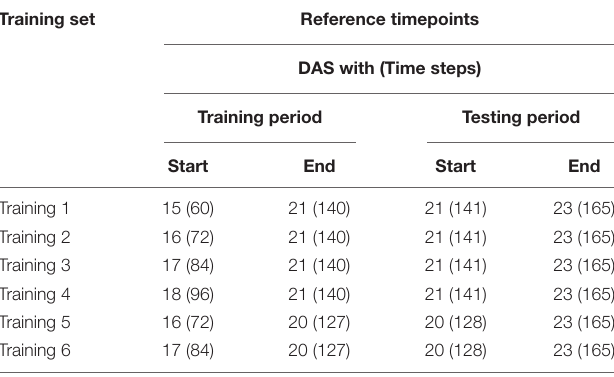
TABLE 1 | Summary of reference points of each dataset with two-time scales used in the